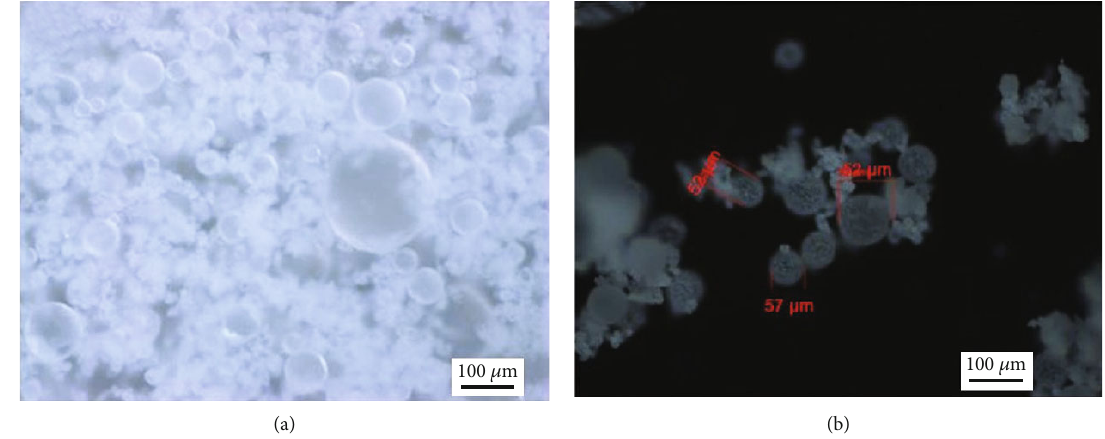
Figure 6: Optical microscopy images of copaiba oil microcapsules (a) raw material and (b) the material after washing.